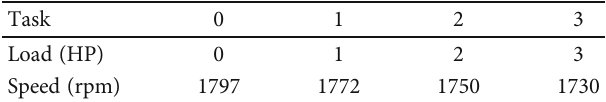
Table 3: Transfer scenarios in